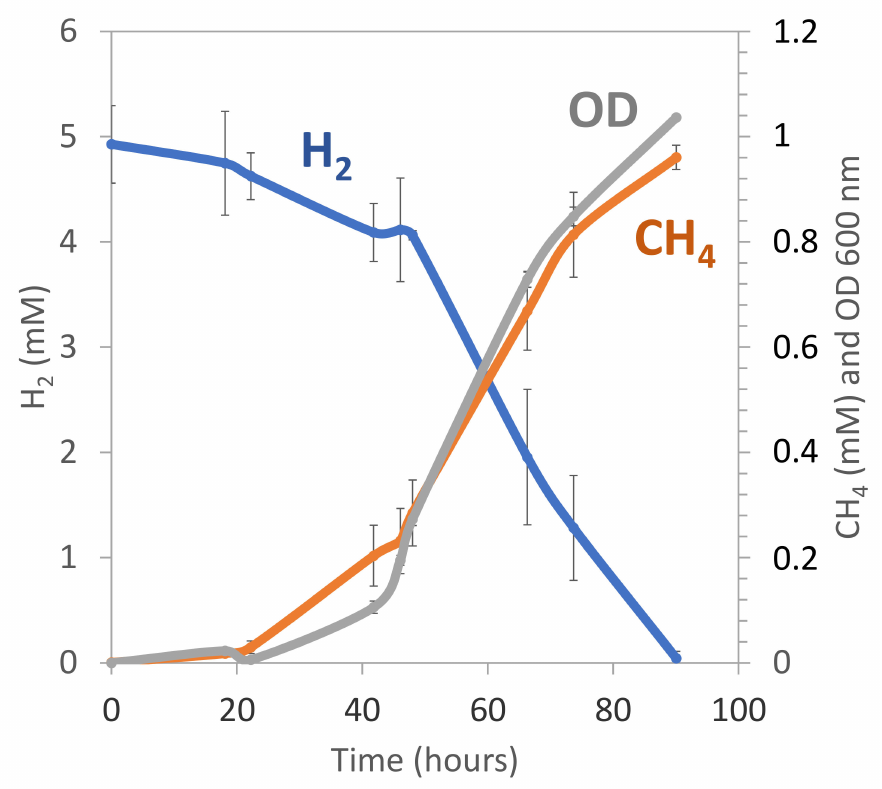
Figure 6. Kinetics of growth (optical density OD 600 nm × 10), hydrogen (H 2 ) and methane (CH 4 ) production of Methanobacterium sp. strain CAN. Values are means ± standard deviations of tripli- cated